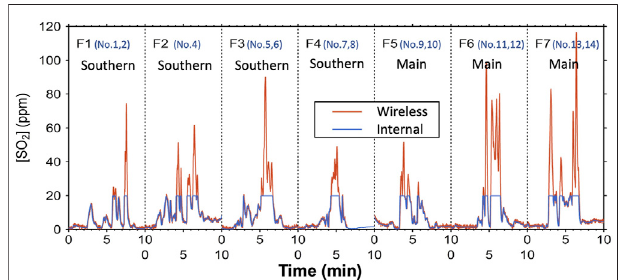
FIGURE 4 | Temporal variations in the SO 2 concentration of the gas drawn into SelPS at Aso volcano recorded in the internal memory (blue line), along with that sent to the operator through the wireless module of SelPS and recorded on the PC (orange line). Labels F1-F7 denote the individual fl ights. The duration when the SO 2 concentration recorded on the PC (shown by the orange line) was higher than that recorded on the internal memory of SelPS (the blue line) corresponds to the SO 2 signal turned P2 on for sampling (see text for the